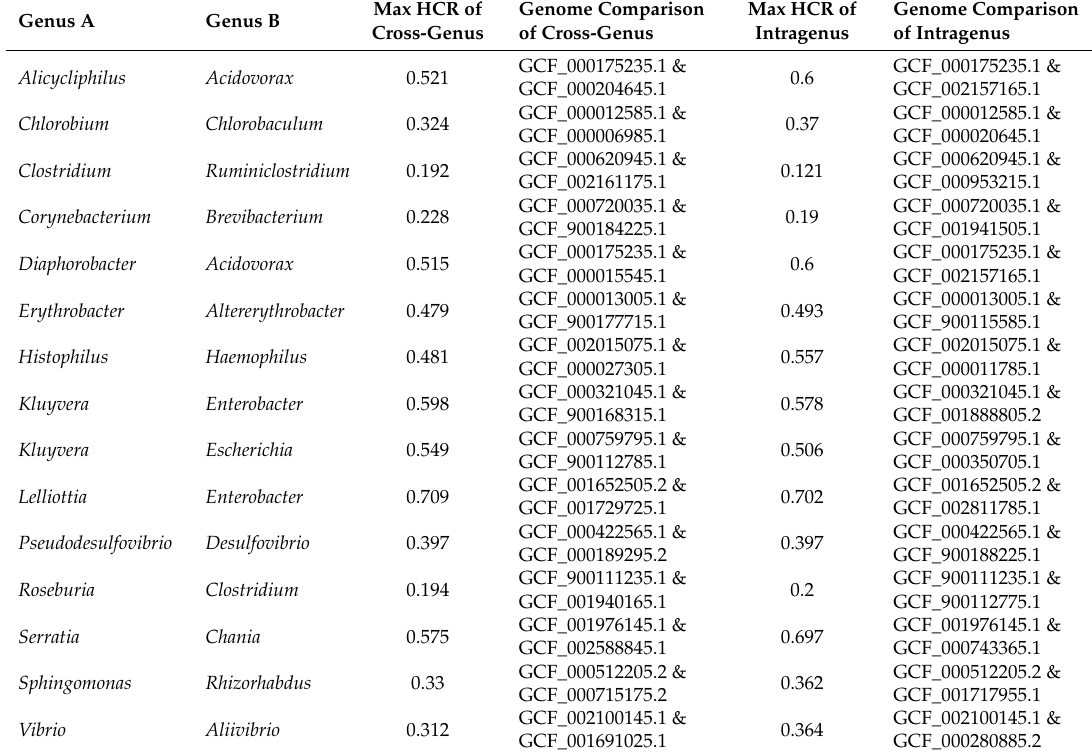
Table 3. Fifteen pairs of genera with ambiguous classification at the genus level. HCR: homologous coverage